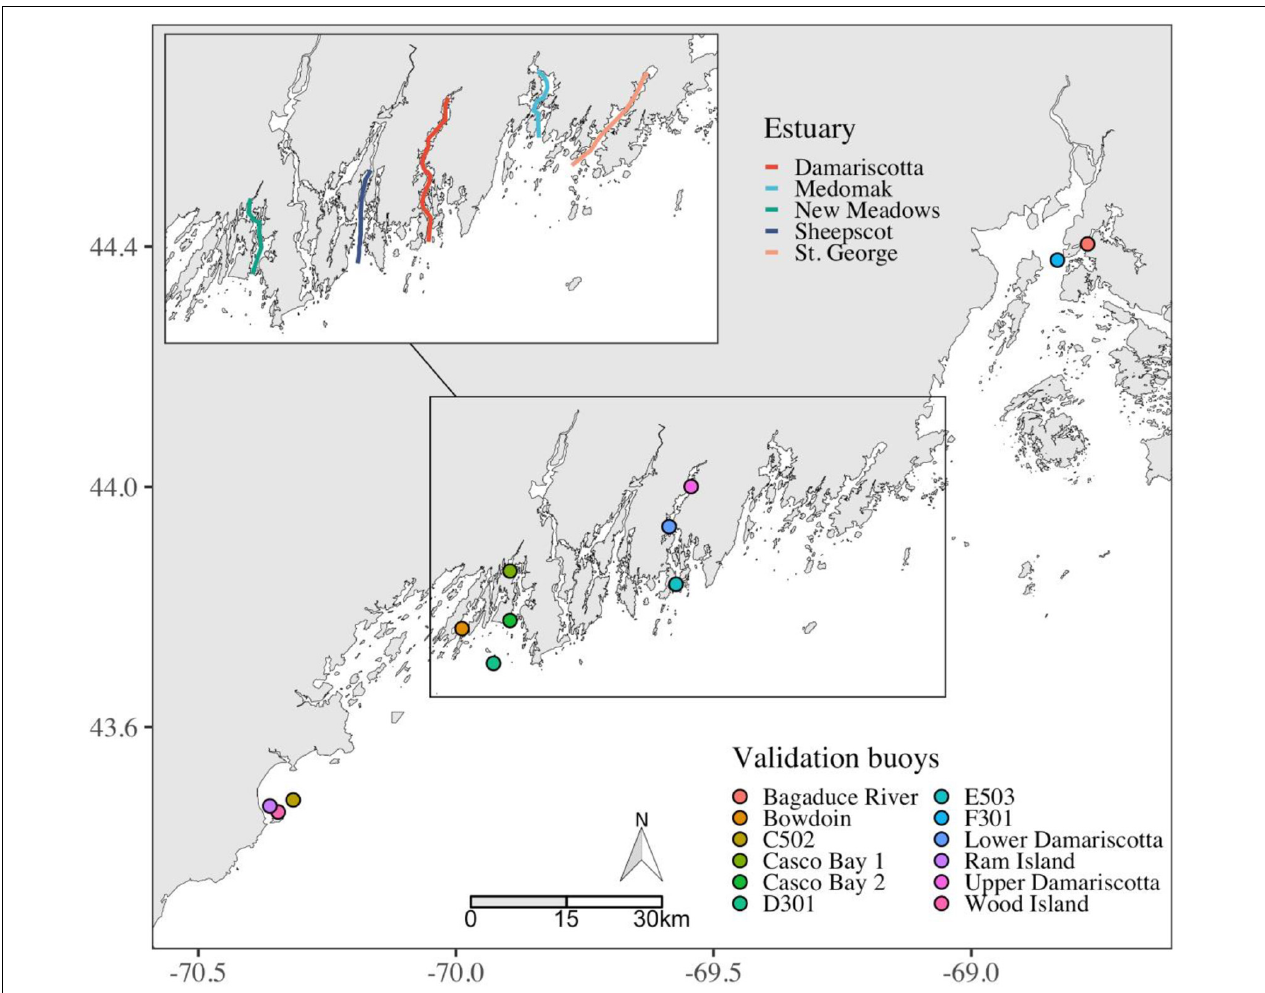
FIGURE 1 | Locations of buoys in the GoM whose environmental data we use for validation of the remote-sensing products computed along five transects in different Maine estuaries.